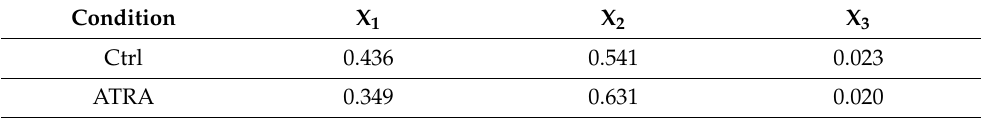
Table 2. The fractions of X1, X2, and X3 species at steady state using C1 and C2 values estimated for control and ATRA-treated cells. Notice that X1, X2, and X3 decreased by 25%, increased by 17%, and decreased by 10%, respectively, in ATRA-treated cells compared to